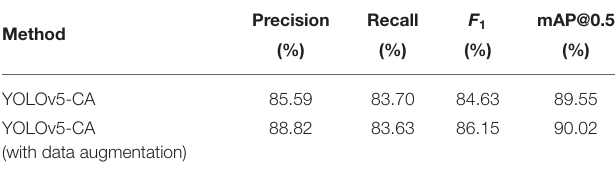
TABLE 3 | Comparison of different GDM